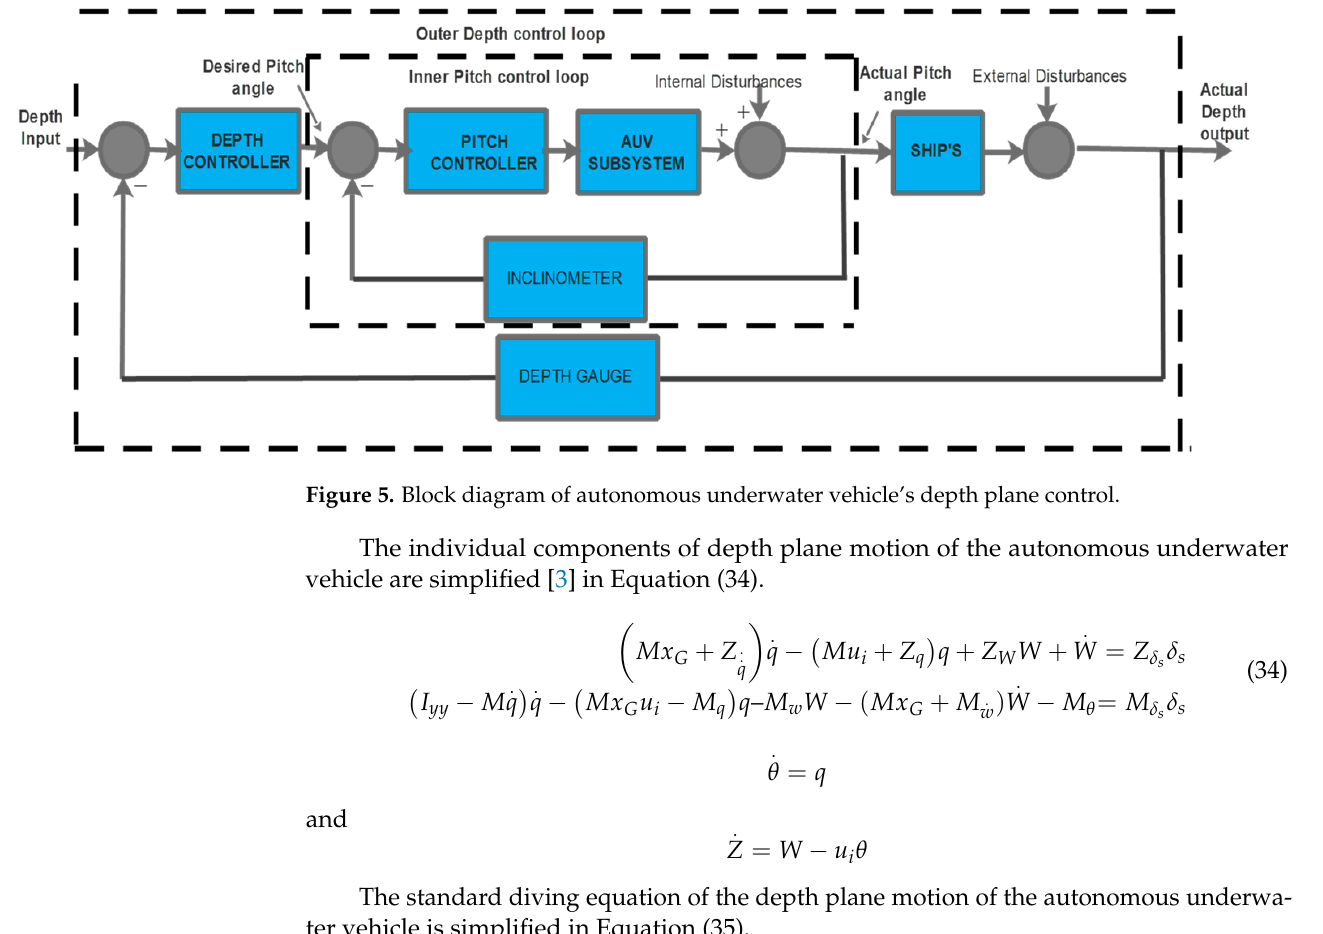
Figure 4. Autonomous underwater vehicle’s depth plane motion.